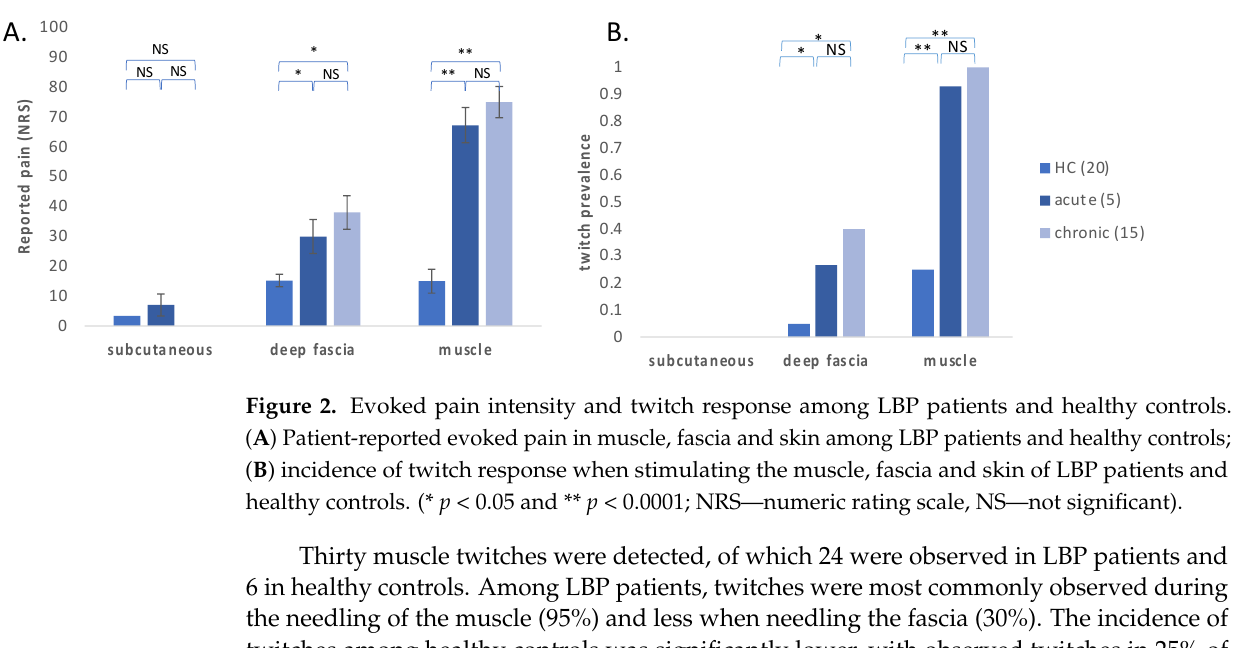
the needling of the muscle (95%) and less when needling the fascia (30%). The incidence